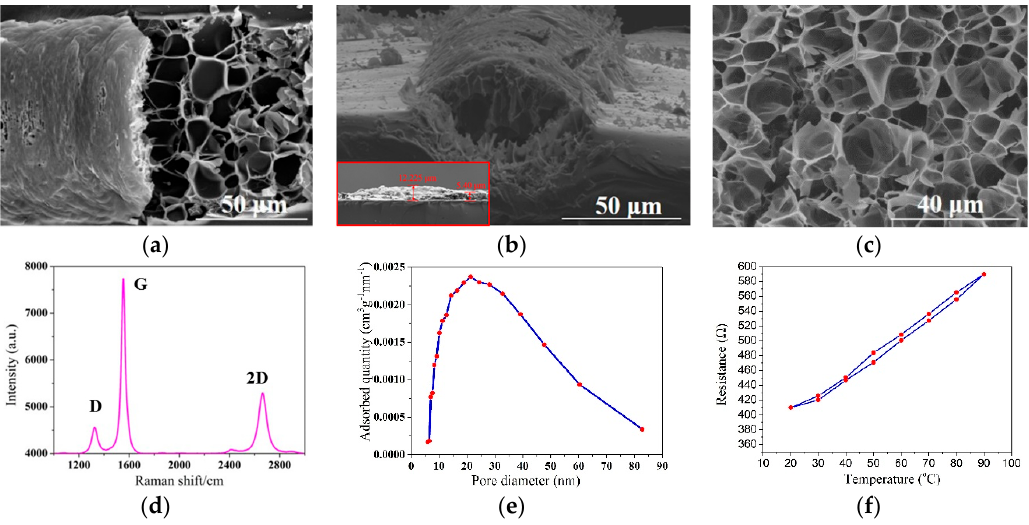
Figure 3. ( a ) SEM image of the laser irradiated PI; ( b ) Side view of ( a ); ( c ) Amplified view of ( a ); ( d ) Raman spectroscopy of the laser irradiated PI; ( e ) The pore diameter distribution curve of the laser direct-write PI; ( f ) Resistance change of the laser irradiated PI with temperature.